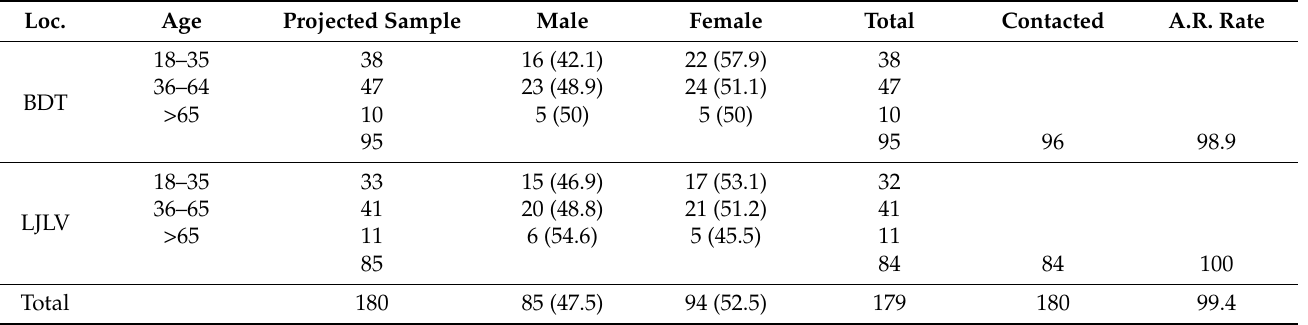
Table 2. Sampling projections and respondents recruited distribution by age, sex, and rural locality within the Los Horcones River